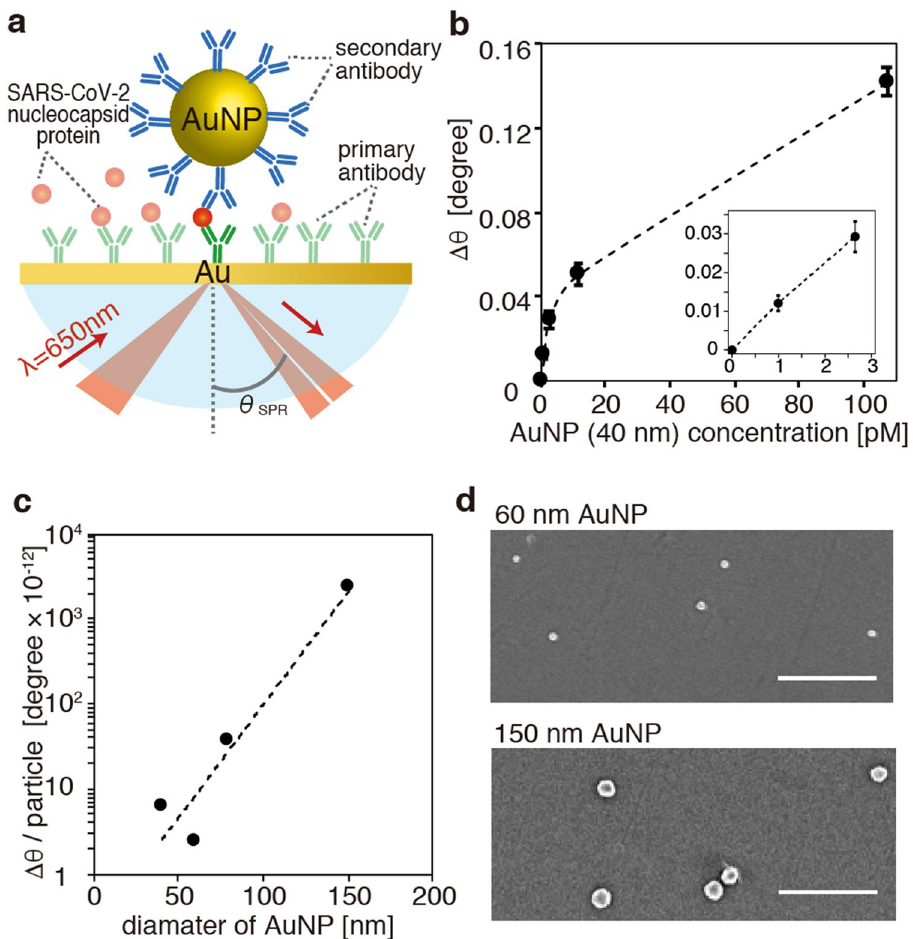
Figure 1. ( a ) Schematic of SPR measurement of SARS-CoV-2 nucleocapsid protein (N protein) using gold nanoparticles (AuNPs). ( b ) SPR angular shift (∆θ) as a function of concentration of AuNPs of 40 nm diameter. The inset shows an enlarged view in the low concertation region. ( c ) Angular shift induced by a single AuNP for AuNPs of various diameters. ( d ) SEM images of AuNPs of 60 nm and 150 nm diameters remaining on the gold- coated chip substrates after the SPR measurements in ( c ). The scale bars correspond to 1